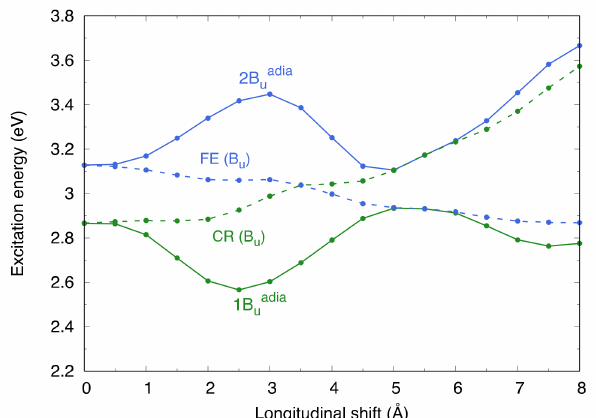
Figure 2. Excitation energy profiles (TDA- ω B97X-D/6-31G*) of B u adiabatic (adia, solid) singlet exciton states and B u FE and CR states (dashed) for the PDI dimer along the longitudinal translation coordinate. The computed energy profiles of exciton states are the result of the interactions between CR and FE states of the same symmetry. When the interactions are large, the adiabatic exciton energies differ considerably from the diabatic energies.